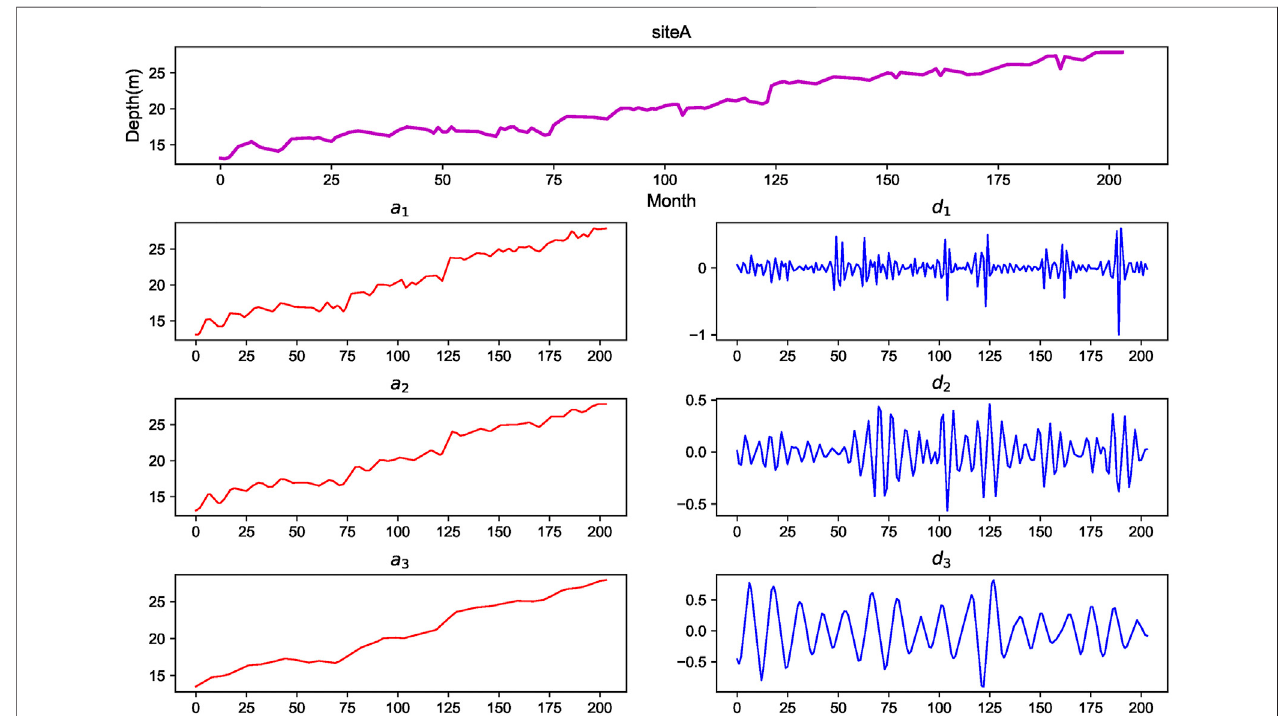
FIGURE 6 | Decomposition of the time series of site